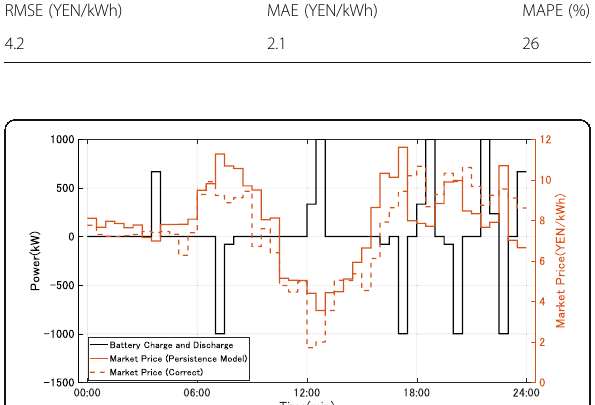
Fig. 1 (Abstract P12). Dispatch control for BES at case 2